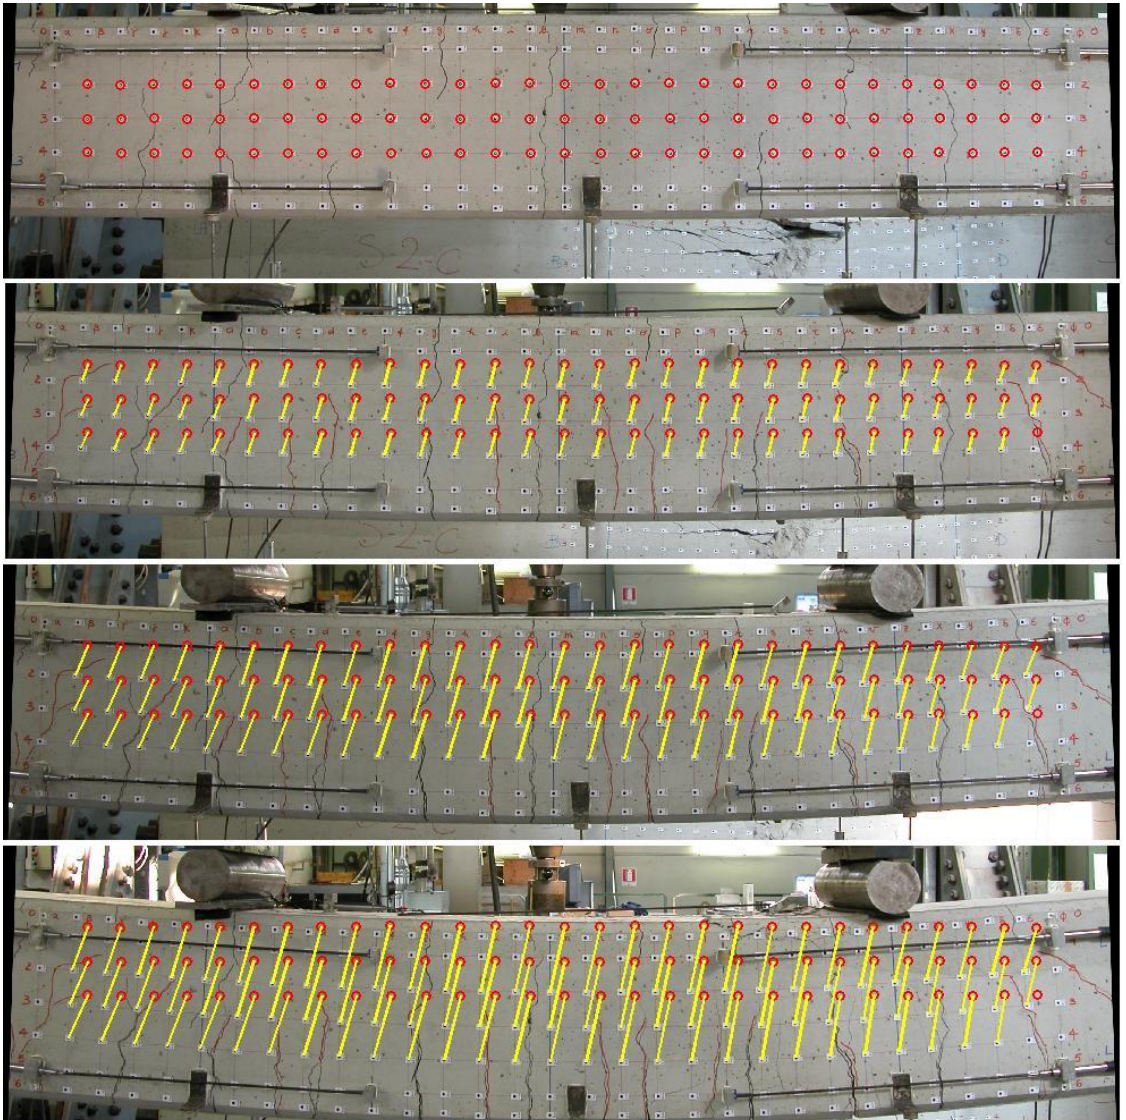
Figure 5. Some rectified images of the sequence and the magnitude of the displacements.